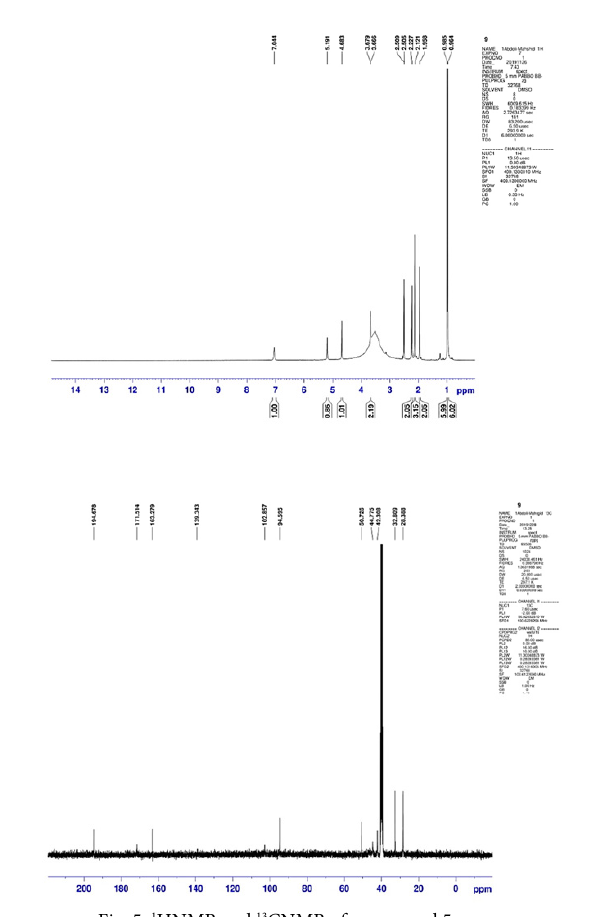
Fig. 5. 1 HNMR and 13 CNMR of compound Figure 5. 1 HNMR and 13 CNMR of compound 5